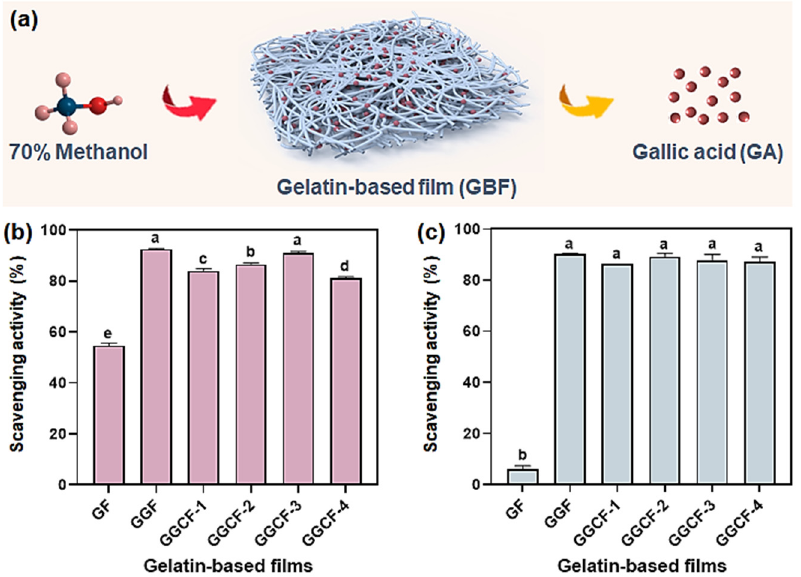
Figure 8. Schematic diagram of the release of GA from a GBF in an aqueous methanol solution ( a ); ABTS ( b ) and DPPH ( c ) radical scavenging capacities of GBFs. The results are expressed as the means ± SD (n = 3), the columns marked with various lowercase letters are significantly different from each other at p < 0.05.